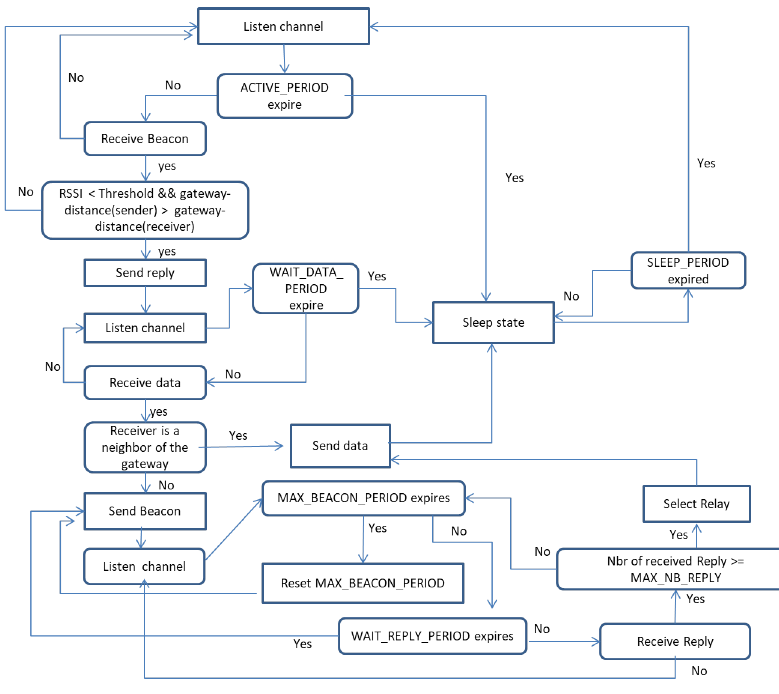
Figure A1. The flowchart of